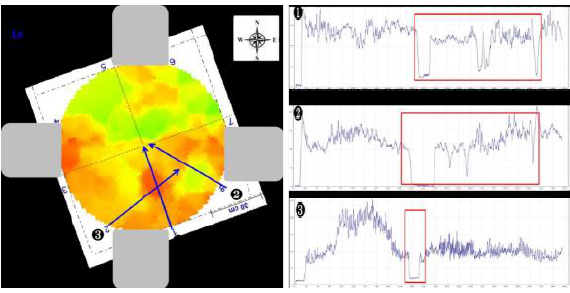
Figure 7. Cross-sectional scans and stress wave resistance cytometry results of No.1 wooden (height 136cm)